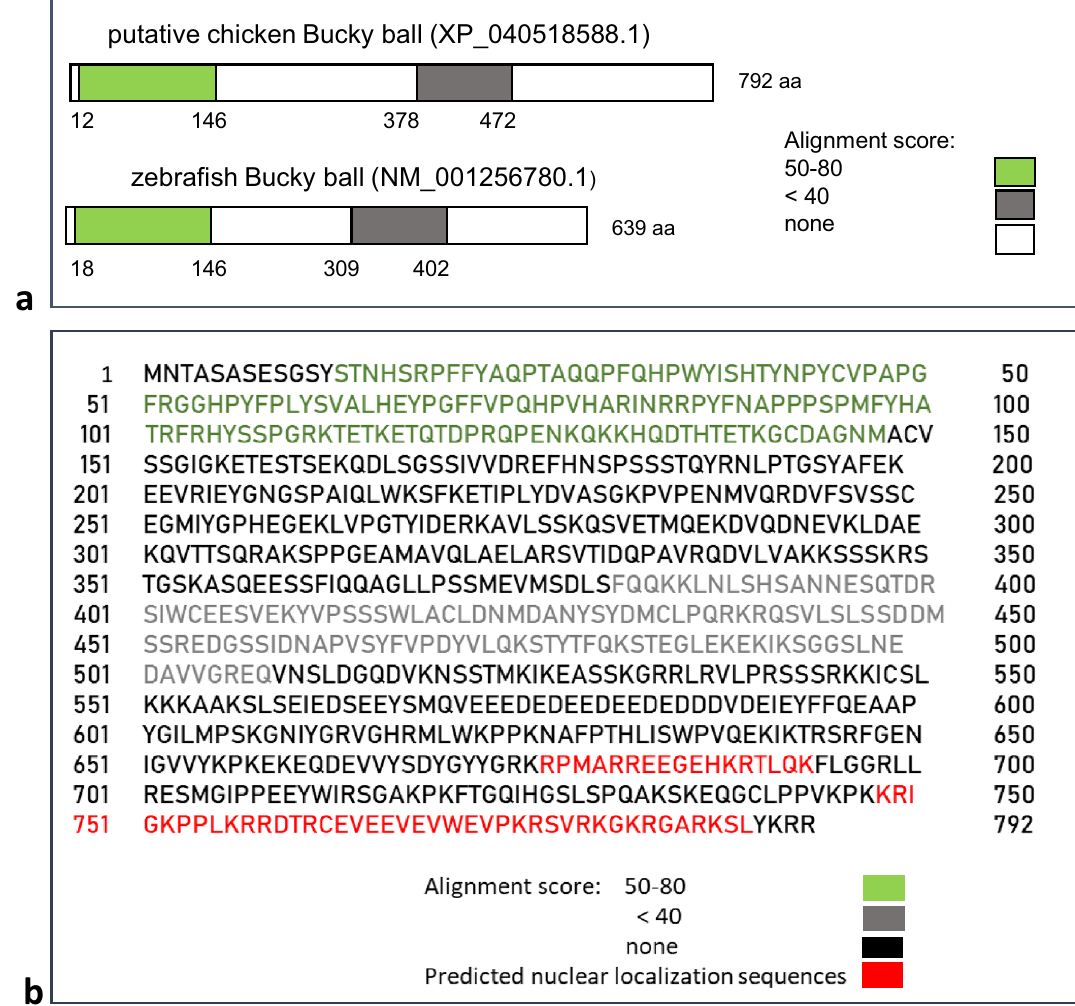
Figure 1. Regions of partial amino acid homology for chicken and zebrafish Bucky ball. ( a ) Homology regions between the predicted chicken (upper panel) and zebrafish Bucky ball amino acid sequences (lower panel). ( b ) Amino acid sequence of LOC 420748 with marked strings of homology to the zebrafish Bucky ball sequence and with highlighted positions of the predicted nuclear localization sequences. The nuclear localization sequences were predicted by cNLS mapper (https:// nls- mapper. iab. keio. ac. jp/ cgi- bin/ NLS_ Mapper_ form.